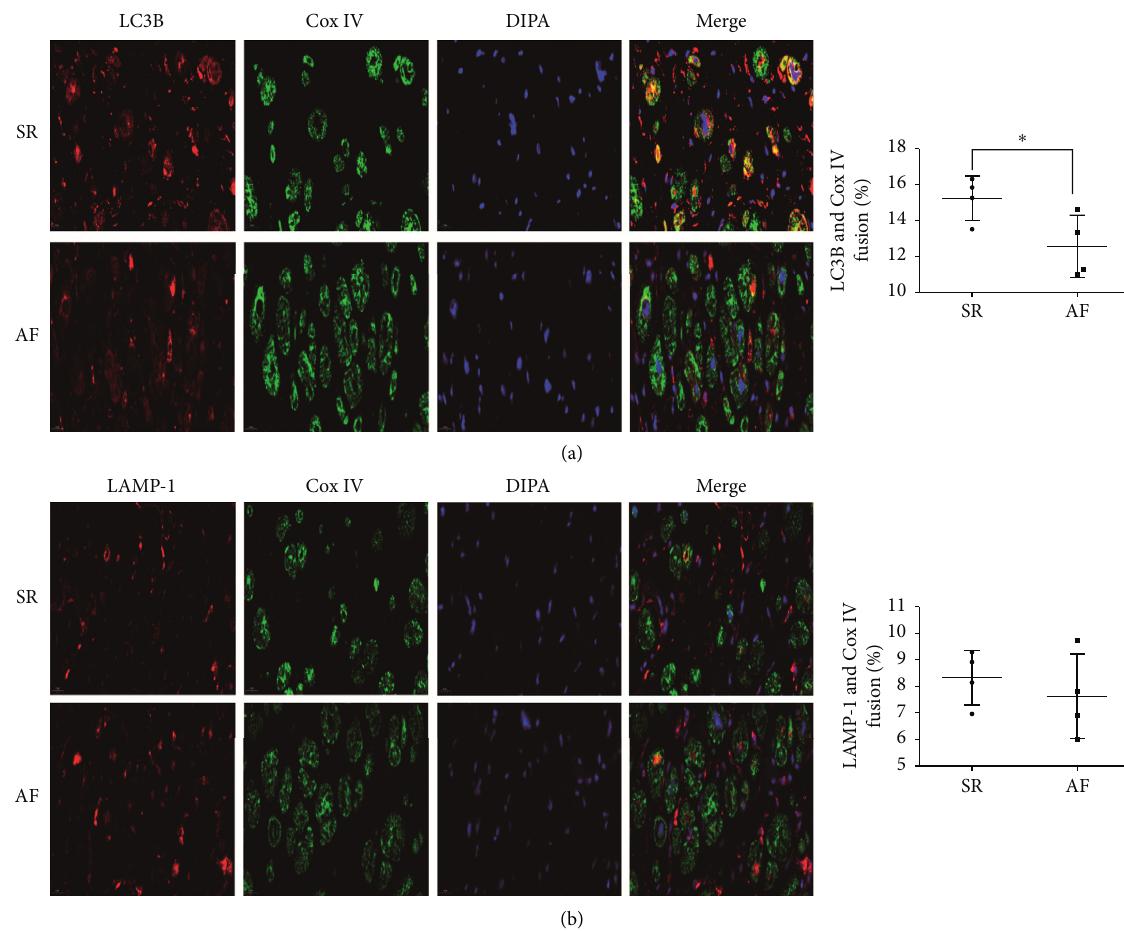
Figure 4: Decreased engulfment of mitochondria into autophagosomes in atrial myocytes of patients with chronic AF ( n � 4 per group, scale bar � 20 μ m). (a) Representative dual immunofluorescence images and semiquantitative analysis colocalization of Cox IV and LC3B in RAA. (b) Representative dual immunofluorescence images and semiquantitative analysis colocalization of Cox IV and LAMP-1 in RAA. ∗ p < 0.05 vs the SR group. SR, sinus rhythm; AF, atrial fibrillation; RAA, right atrial